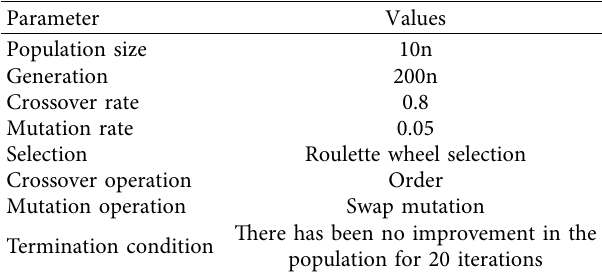
Figure 6: Parameter setting for crossover and mutation. Table 9: The parameter setting for